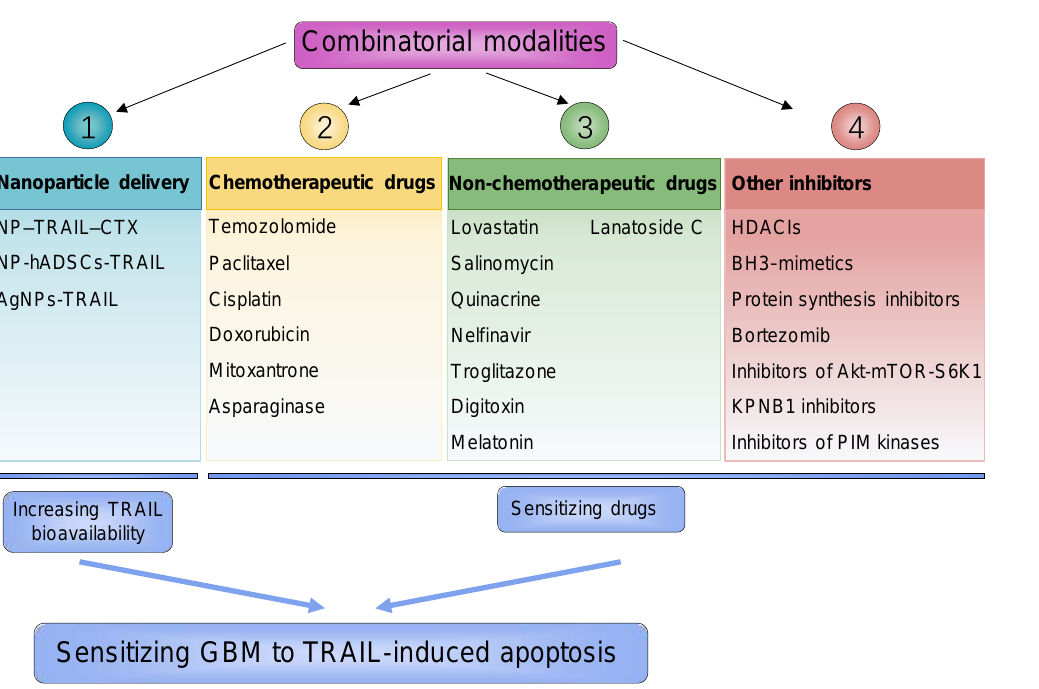
Figure 2. Strategies for sensitizing GBM to TRAIL-induced apoptosis. NP–TRAIL-CTX, nanoparticle coated with chitosan- polyethylene glycol-polyethyleneimine copolymer and chlorotoxin; NP-hADSCs-TRAIL, nanoparticle-engineered human adipose-derived stem cells overexpressing TRAIL; AgNPs-TRAIL, silver nanoparticles-TRAIL; HDACIs, histone deacetylase inhibitor; BH3-mimetics, Bcl-2 homology 3 mimetics; KPNB1, karyopherin β1.